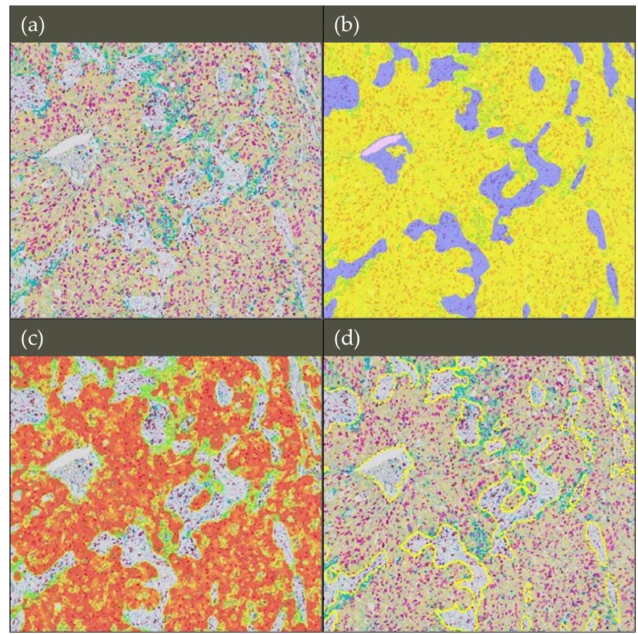
Figure 5. Tissue classification using the random forest classifier in non-small cell lung cancer tissue (20 × magnification). ( a ) The multiplexed immunohistochemistry (mIHC) image was scanned with a Nanozoomer 2.0-HT Scanner (Hamamatsu photonics, Hamamatsu, Japan). The stains are as follows: Pan-cytokeratin (yellow), CD8 (brown), Ki67 (purple), PD-L1 (teal) and hematoxylin (dark purple). ( b ) The random forest classifier in HALO was used to separate the image into three classes: tumor, stroma and microscope glass slide. The classifier mask is shown overlaying the mIHC image where classified tumor regions are shown in yellow, stroma regions in purple, and the microscope glass slide in pale pink. ( c ) The probability threshold used by the random forest to detect tumor regions was increased to 70%. A heatmap is displayed where the red regions represent areas most likely to be tumor regions, and the green regions that are less likely. No mask will appear in areas where pixels have below 70% probability of being in the tumor class. ( d ) The classifier to annotations option was used whereby regions can automatically be annotated from the classification mask; only the tumor has been annotated (shown in yellow).